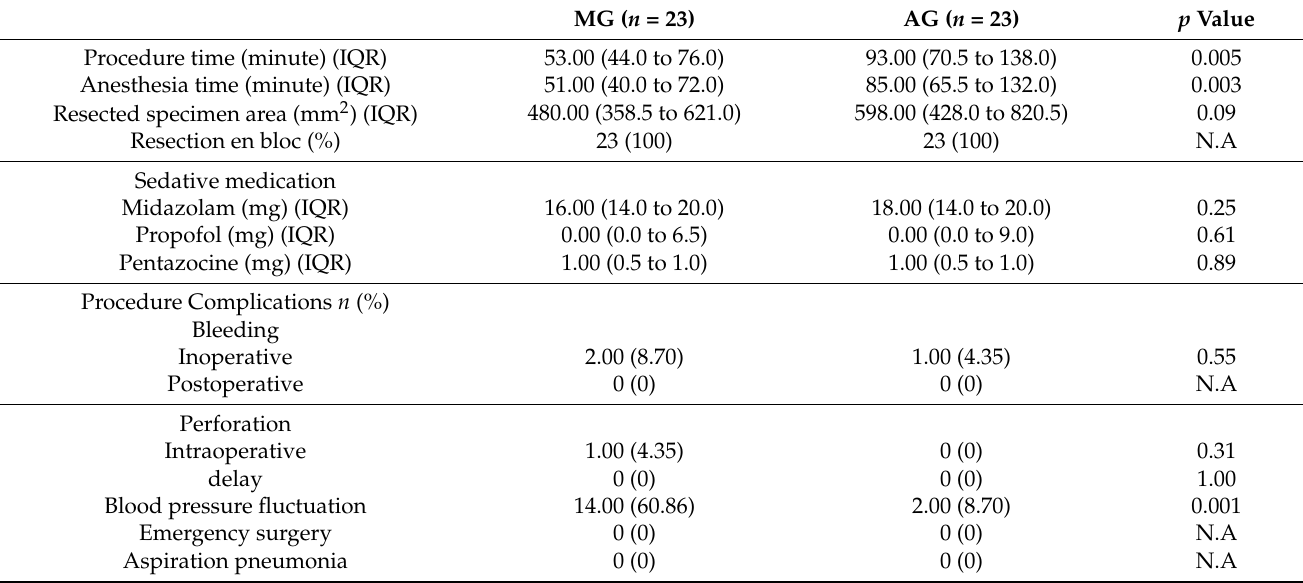
Table 4. Changes in the other outcome and procedure complications.